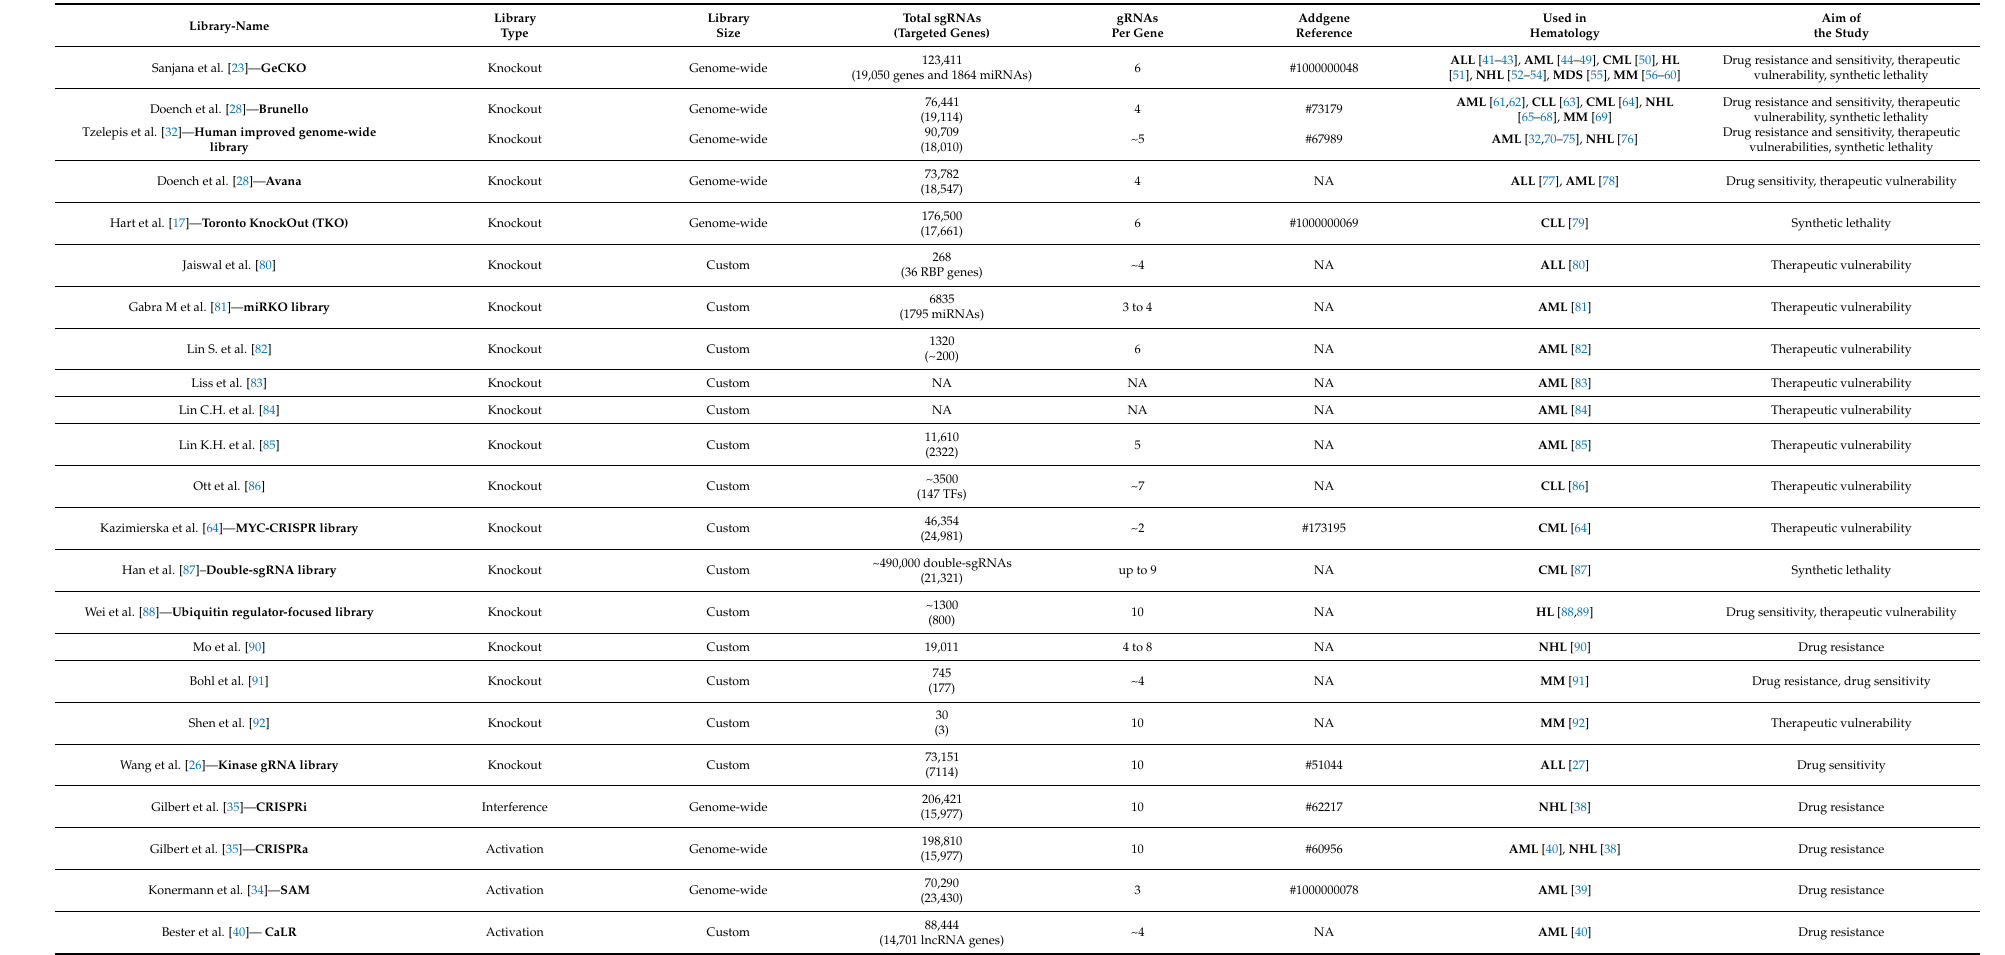
Table 1. Main information of the CRISPR human libraries used in hematological